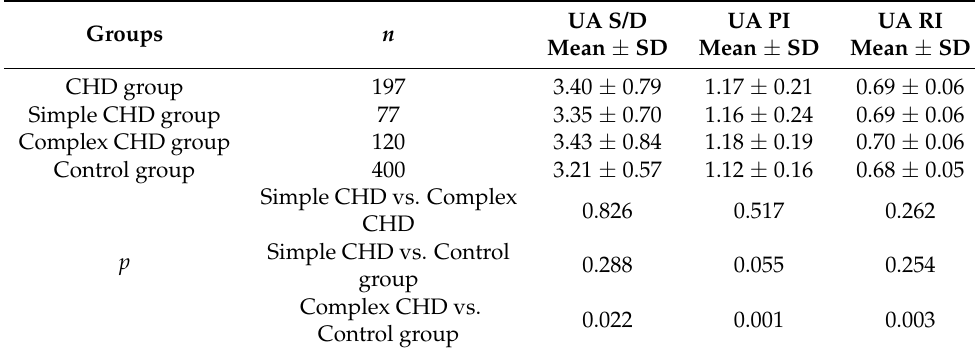
Table 3. Comparison of the UA Doppler indices at 22–24 weeks of pregnancy.